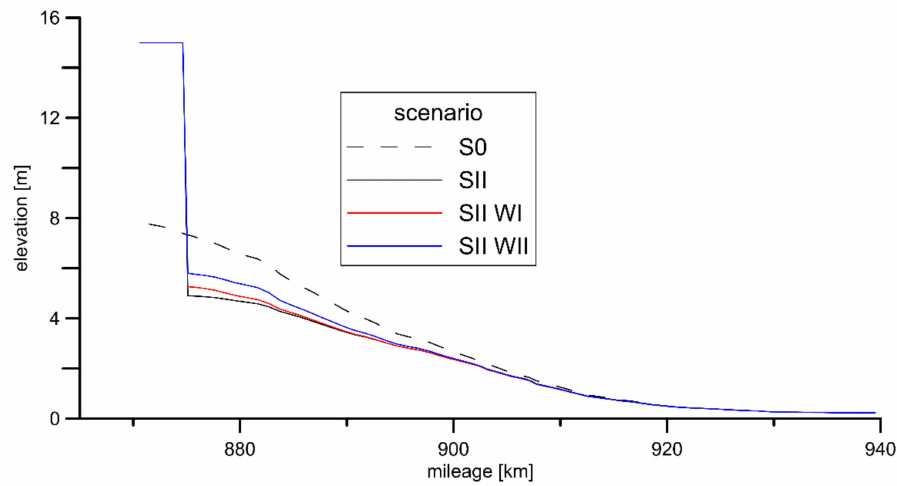
Figure 14. Difference in the bottom elevation between Scenarios S0 and SII, as well as options SII WI and SII WII for the SNQ flow for the entire cross section.